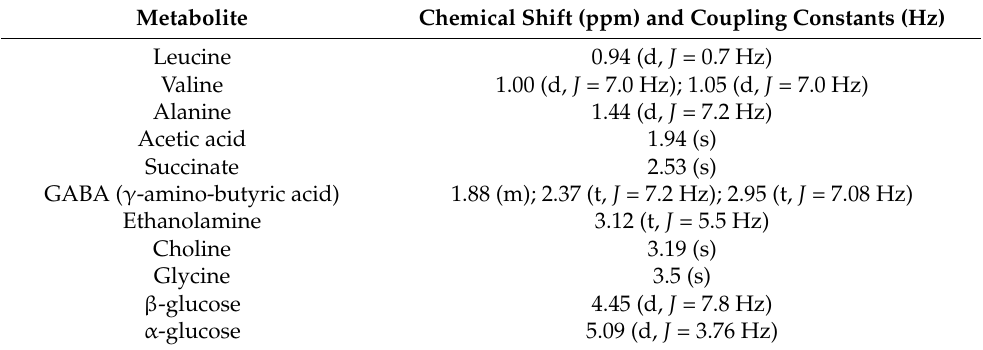
Table 1. Peak assignments for the 1 H-NMR spectrum of tomato leaf in Methanol-d4 (MeOD 4 ).